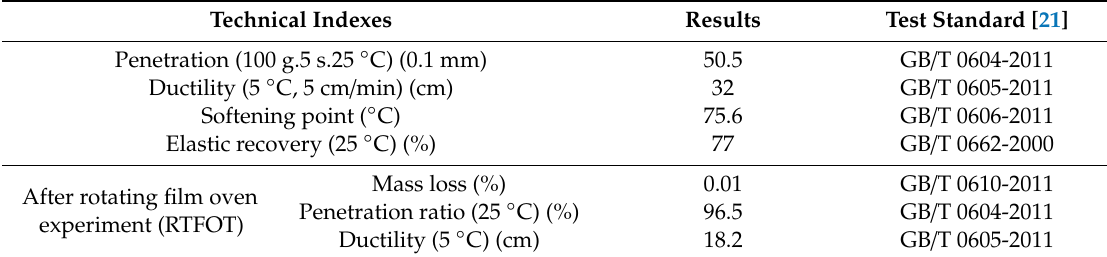
Table 2. Technical indexes of SBS modified asphalt binder.